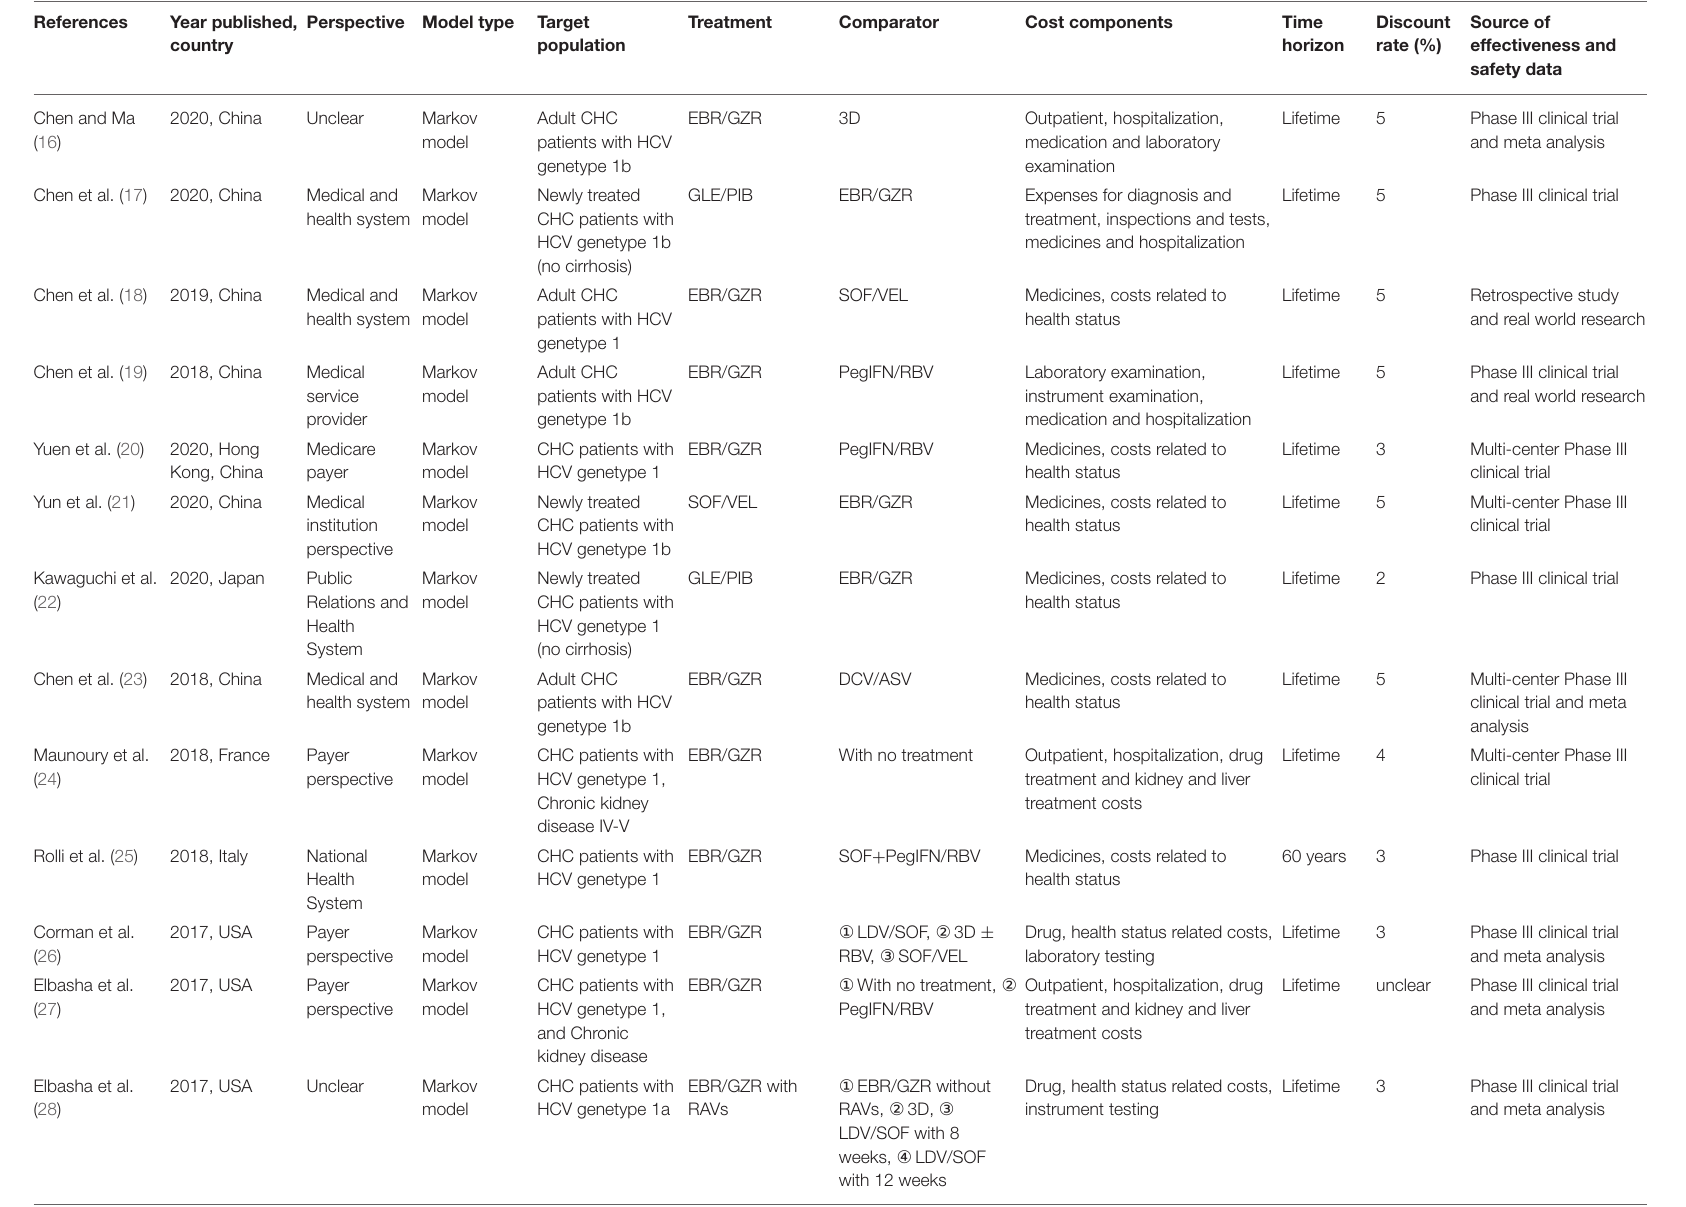
TABLE 1 | General characteristics of the included